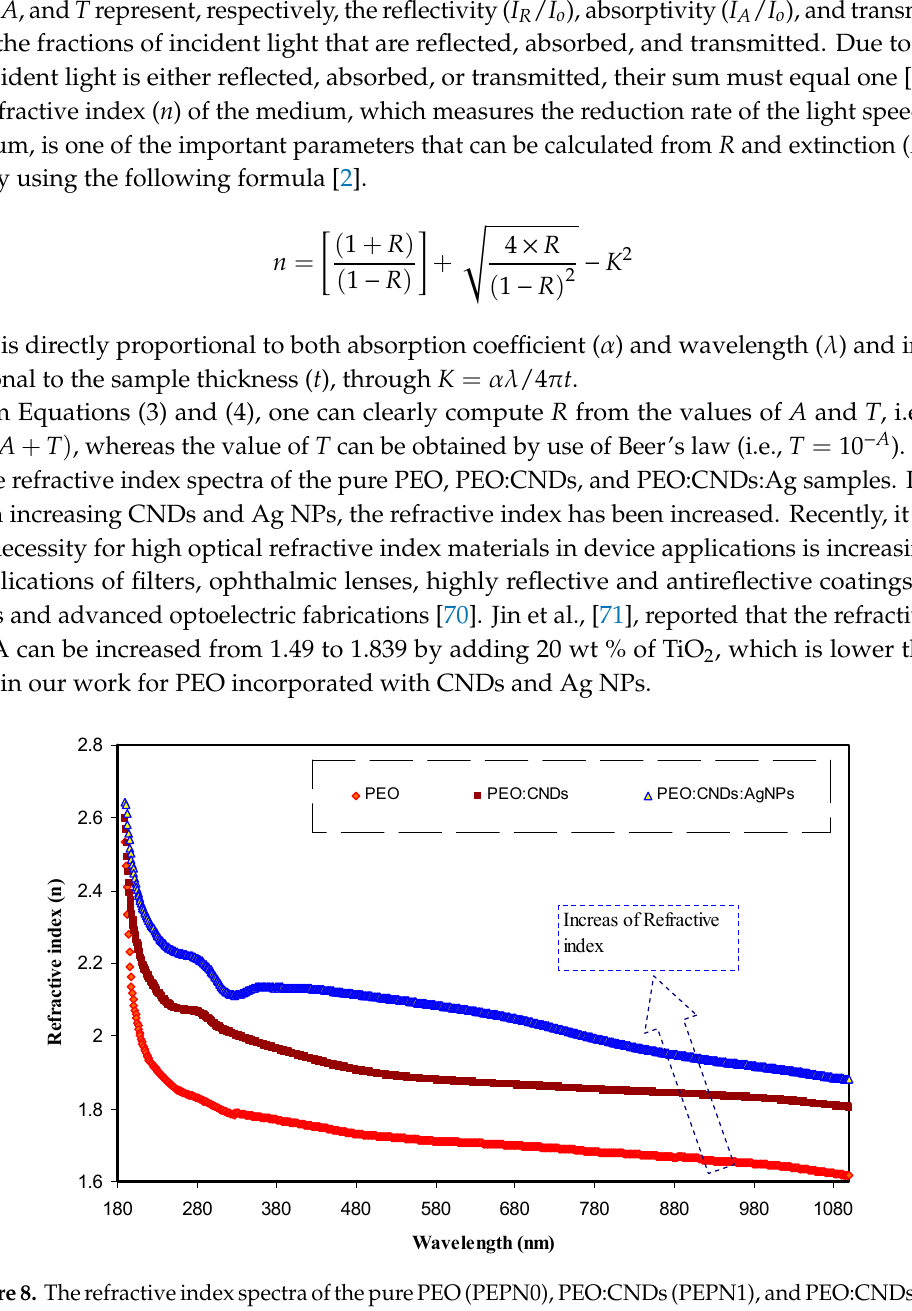
Figure8. TherefractiveindexspectraofthepurePEO(PEPN0), PEO:CNDs(PEPN1), andPEO:CNDs:Ag Figure 8. The refractive index spectra of the pure PEO (PEPN0), PEO:CNDs (PEPN1), and (PEPN2) composite PEO:CNDs:Ag (PEPN2) composite samples.